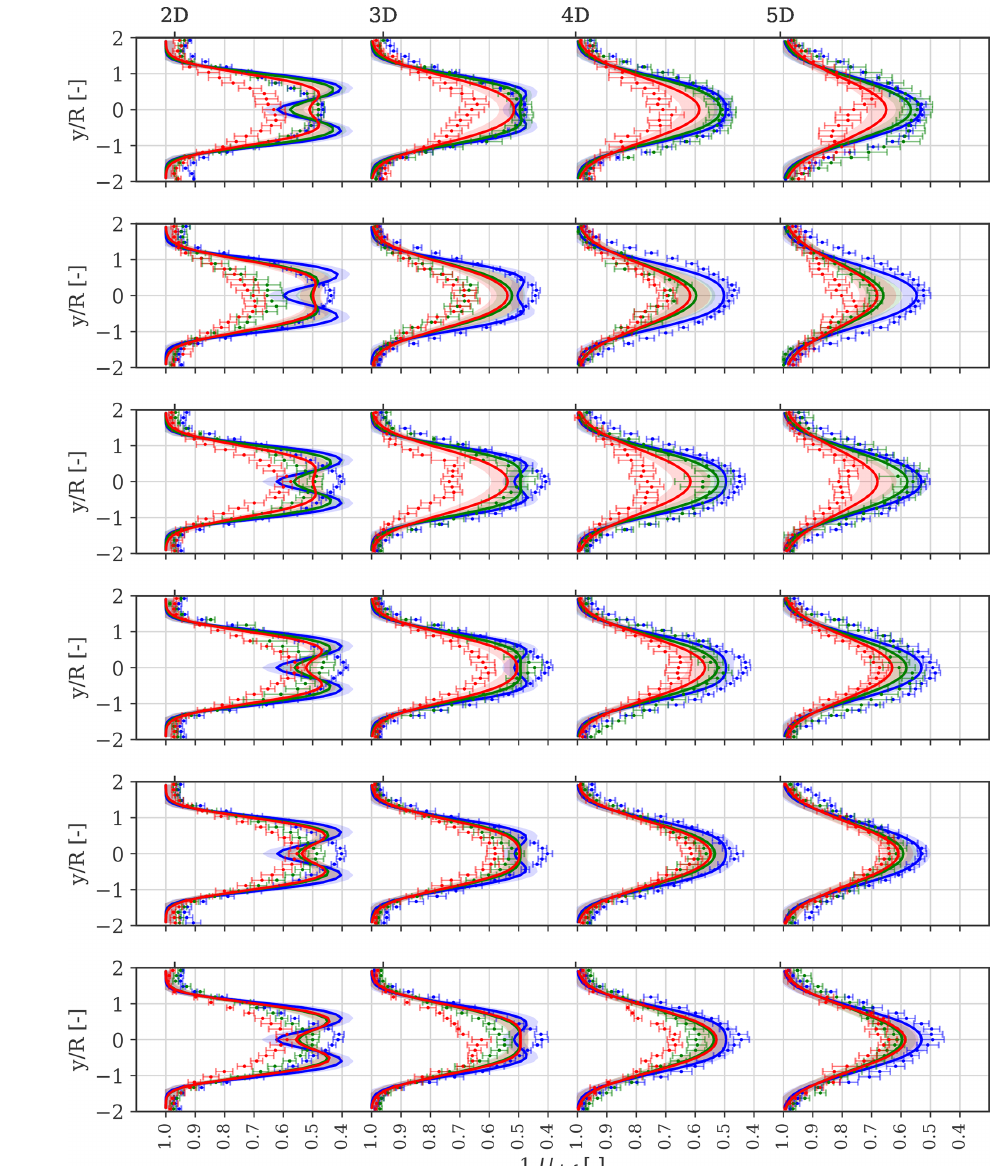
Figure 8. Comparison between measured and predicted ensemble-average spanwise velocity deficit profiles resolved in the MFoR at hub height and obtained at 2, 3, 4, and 5 D behind the rotor (from left to right) and for inflow wind speeds ranging from 3 to 8m/s with a 1m/s bin (from top to bottom panel). The SpinnerLidar-measured (markers) and DWM-model-predicted (solid lines) deficits are shown for each stability class (stable in blue, near-neutral in green, and unstable in red). The error bars represent the measurement uncertainty, while the shaded areas represent the uncertainty in the model predictions; both sources of uncertainty refer to the 95% confidence interval (see Table 1 for details on the inflow wind